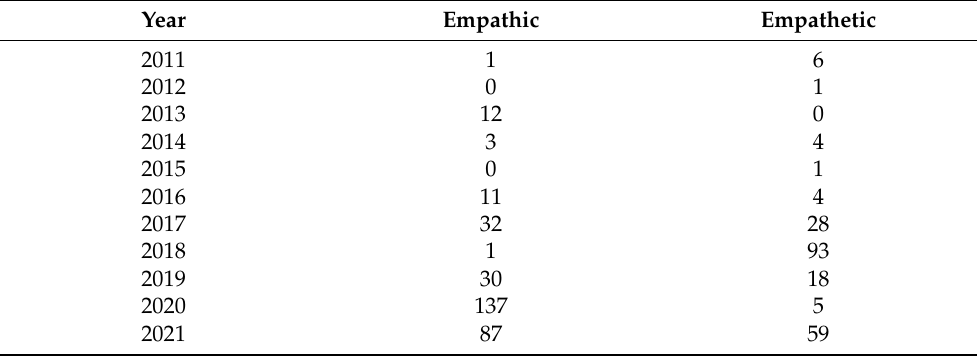
Table 1. Occurrence of “empathic” and “empathetic” in the chosen 59 articles per